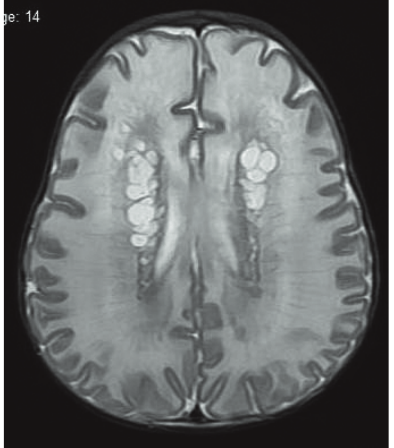
Fig. 3. T2W image shows bilaterally symmetrical cystic cavitation in the deep frontal and periventricular white matter.